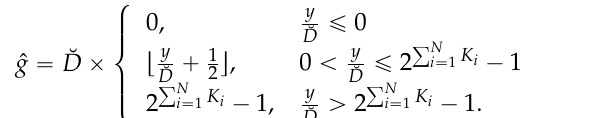
Algorithm 2. (Fast ML Demodulation and Decoding) Let g P